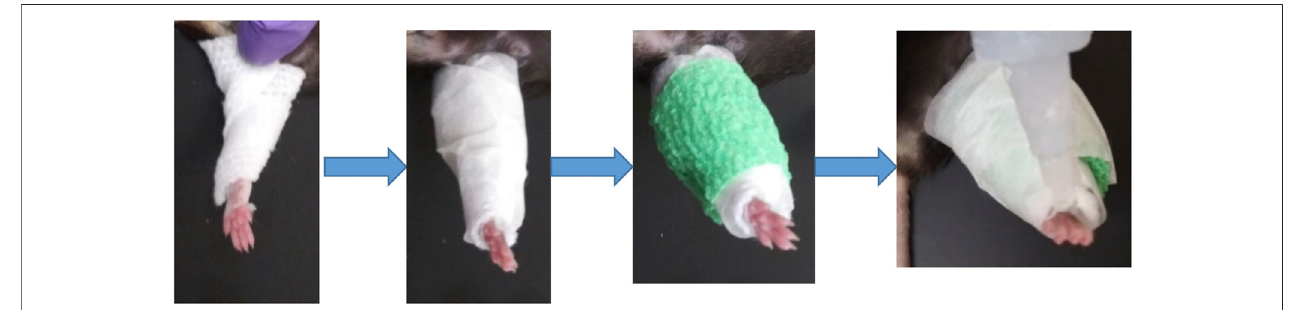
FIGURE 1 | Schematic of single hindlimb immobilization model. Immobilization of the left hindlimb of the mouse. Gauze was secured to the pad of the mouse foot used tapeand wrapped securely aroundthe leg.Tape wasthen wrapped around the gauze, followed by vetwrap. (A) layer oftapeand adrop ofsuperglue at thetop of the foot fi nished the